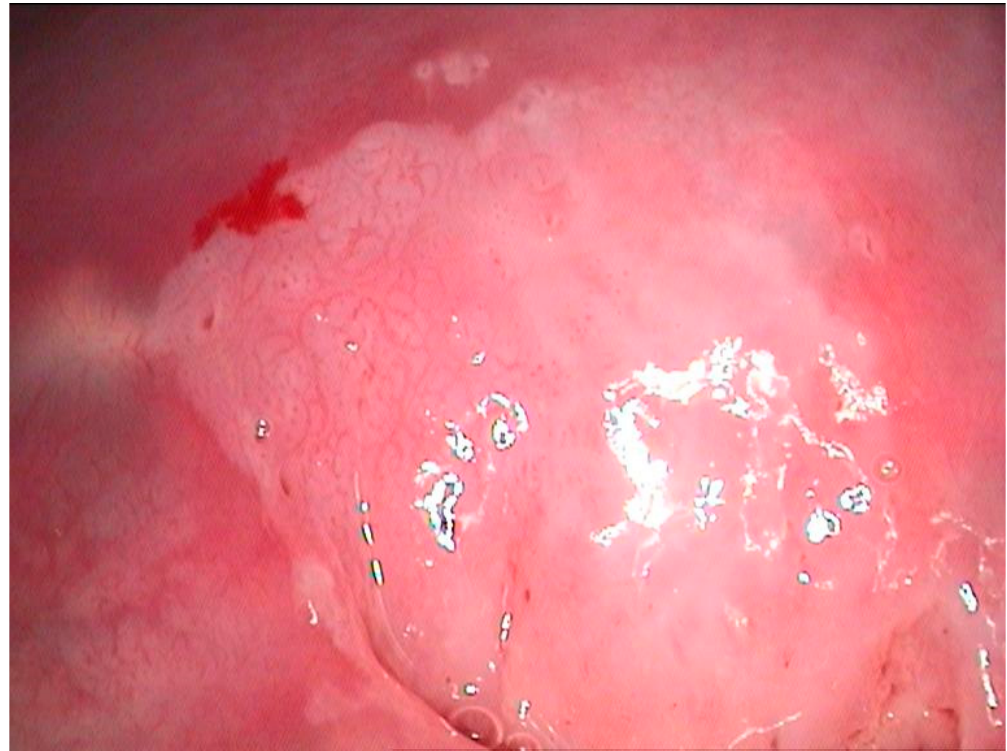
Figure 8. HSIL—colposcopic view of a HSIL PAP showing extensive aceto-white epithelium without a visible border at the distal end (intracervical) with mosaic and punctuation at 11 o’clock.